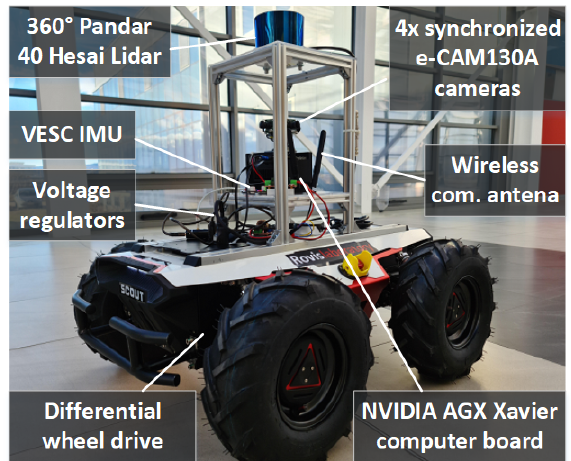
Figure 3. RovisLab AMTU (Autonomous Mobile Test Unit). The robot is a SSWMR (skid-steer wheeled mobile robot) platform equipped with a 360 degree, 40-Channel Hesai Pandar Lidar, 4 × e-CAM130A cameras, a Tinkerforge inertial measurement unit (IMU), and an NVIDIA AGX Xavier computer board for real-time data processing and